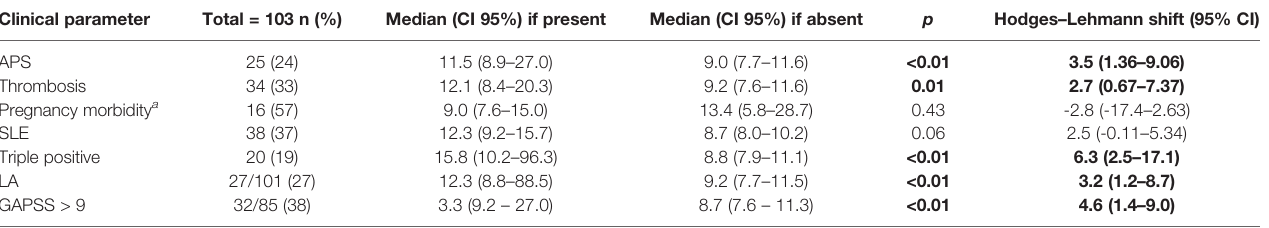
TABLE 5 | Association between aPS/PT IgG antibody levels and APS clinical manifestations. Clinical